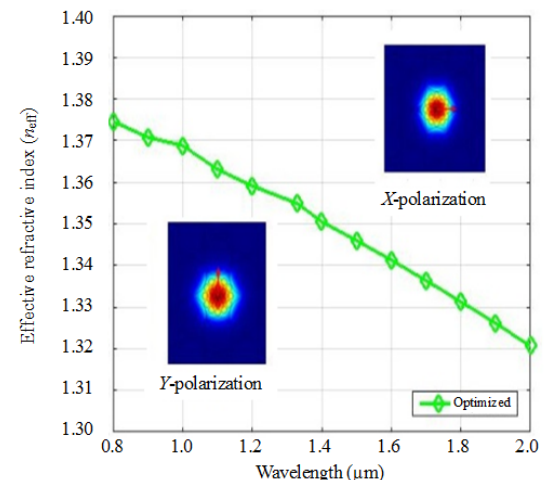
Fig. 2 Effective refractive index verses wavelength in X - polarization fundamental mode for optimized P-OPCF and n = 1.354.